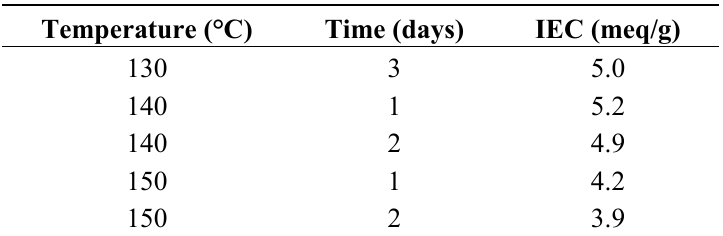
Table 1. Effect of reaction temperature and time on the ion exchange capacity (IEC) of the hyperbranched polysulfone (HPSU).